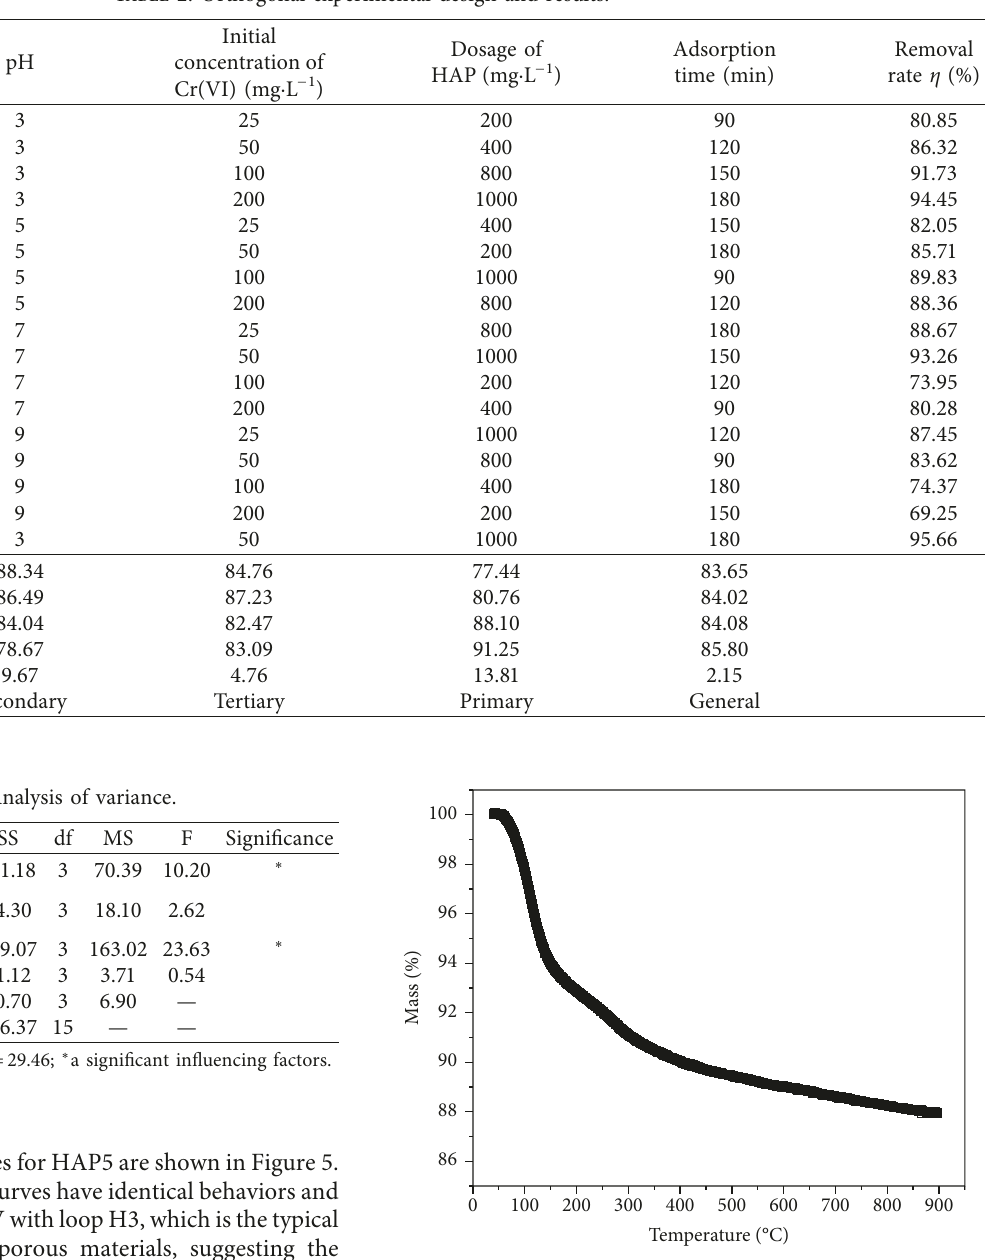
Figure 4: Thermal decomposition of HAP5.